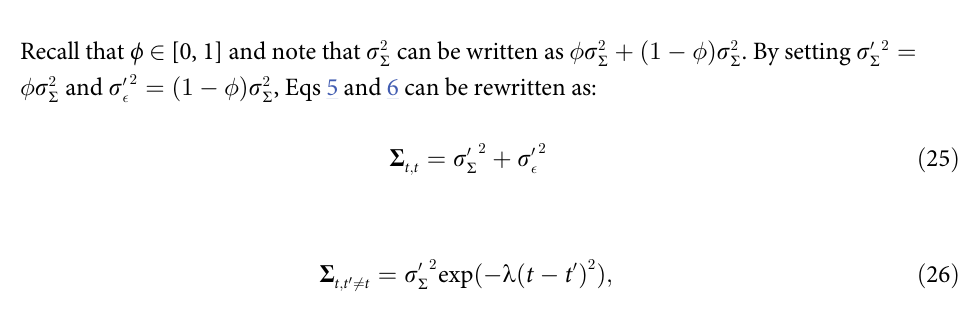
Fig 7. ^ δ (colored lines) and ^ μ s ^ m than Illinois, as can be seen in the spread of ^ m s